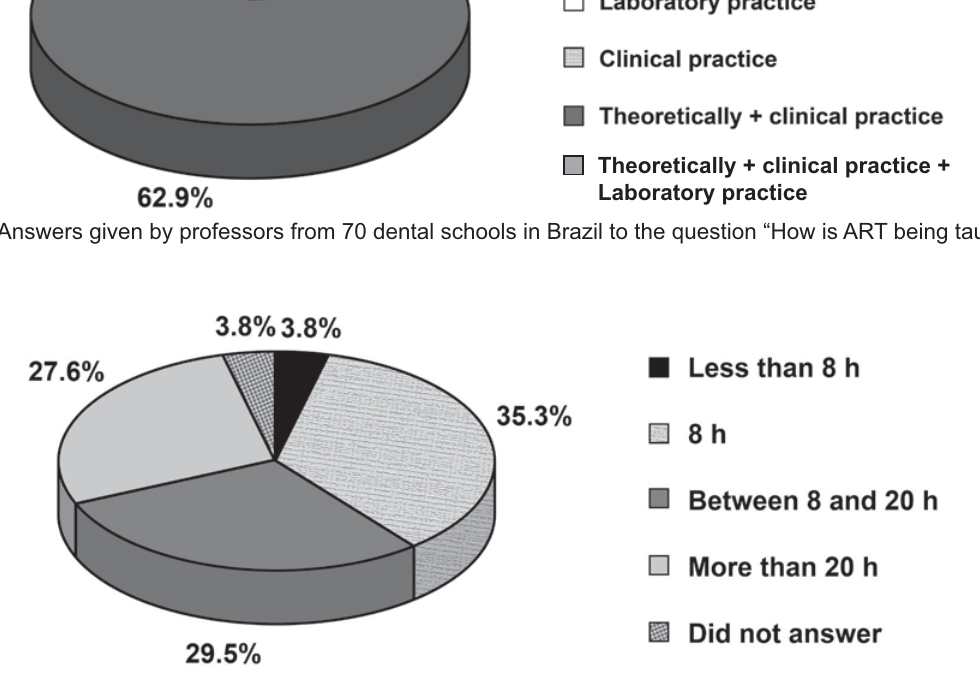
FIGURE 3- Percentage distribution of responses to the question “How much time is spent teaching ART”?